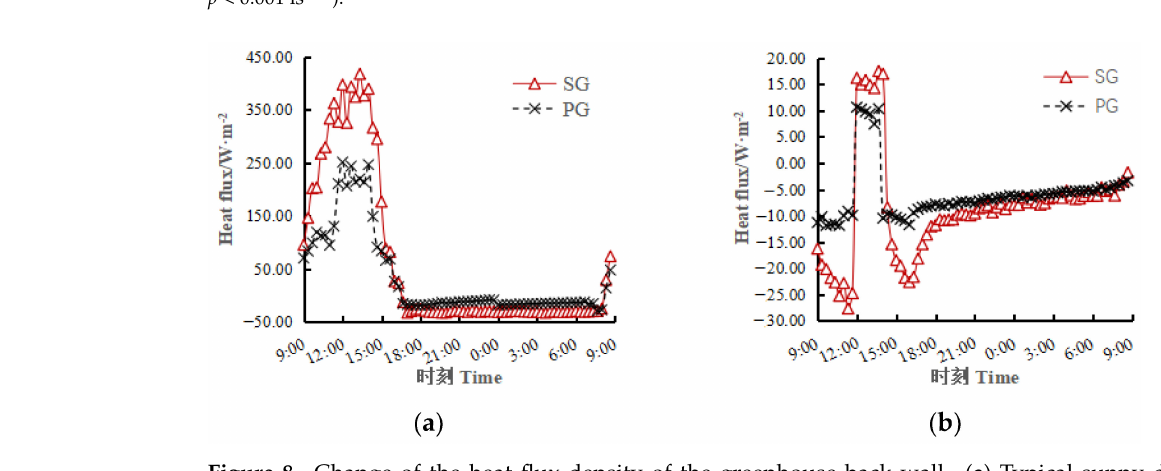
Figure 8. Change of the heat flux density of the greenhouse back wall. ( a ) Typical sunny day. ( b ) Typical cloudy